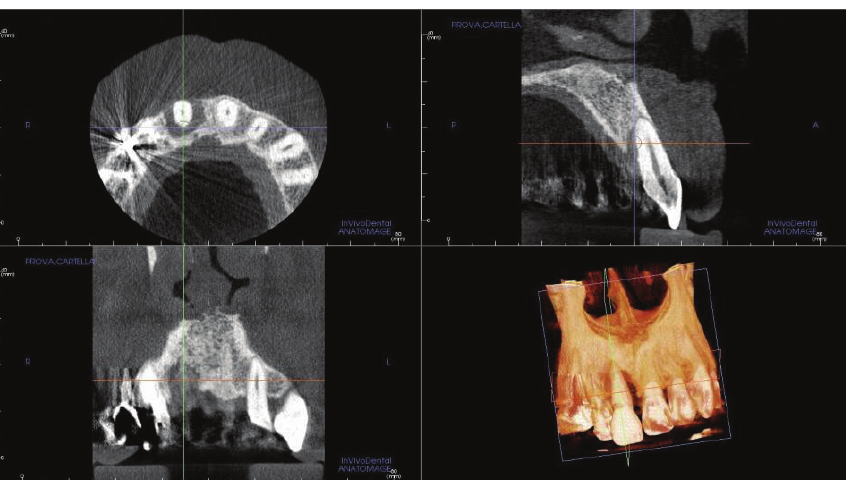
Figure 3: The small field-of-view (FOV) cone-beam computed tomography (CBCT) with three-dimensional (3D) reconstruction by means of an implant navigation software (Invivo Dental 5, Anatomage, San Jose, CA, USA) confirmed the presence of an advanced, localized bone resorption affecting the right-maxillary central incisor.